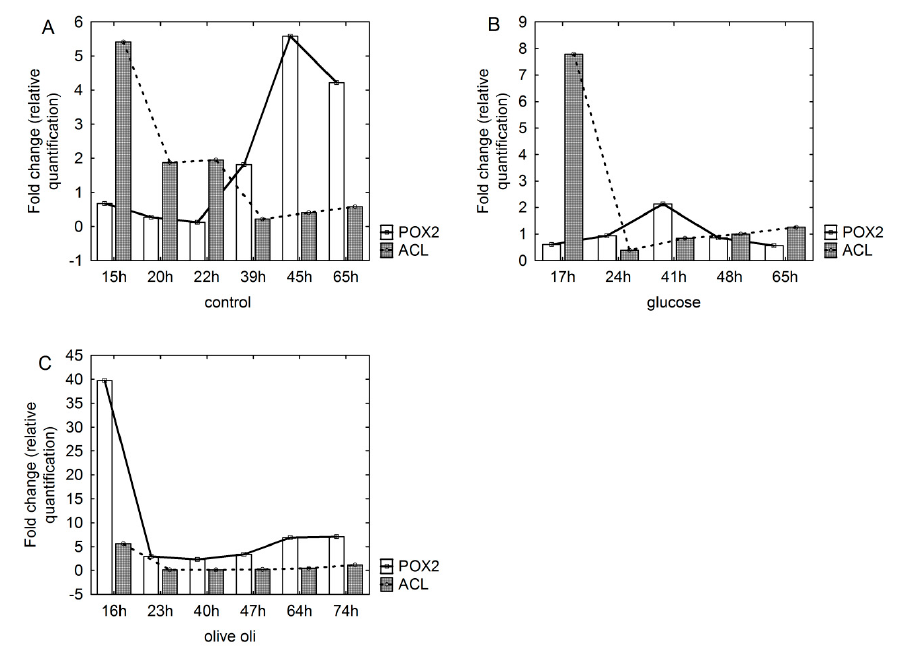
Figure 5. Changes in POX2 and ACL gene expression during Y. lipolytica batch bioreactor culture in ( A ) control YPG medium, ( B ) MG7 medium (containing glucose) and ( C ) MO5 medium (containing olive oil).